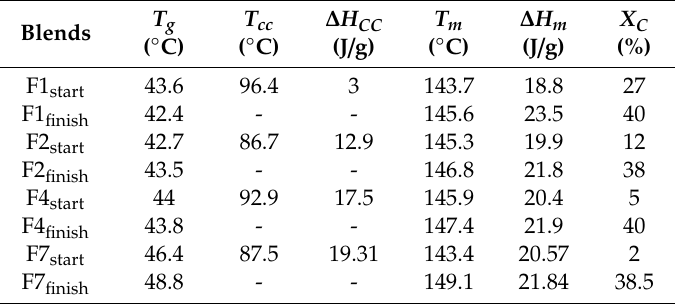
Table 5. DSC results for F1, F2, F4, and F7 formulations at the beginning and at the end of the migration test (first heating).